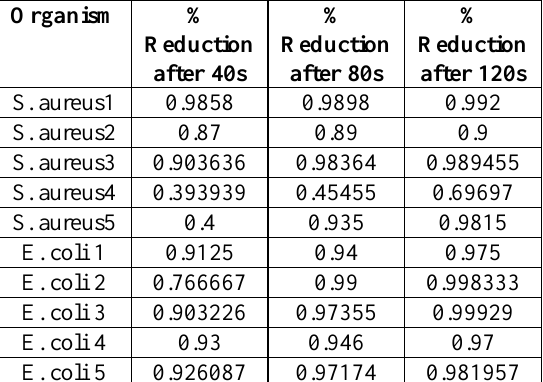
Table 2: The effect of plasma treatment time on different bacterial isolates